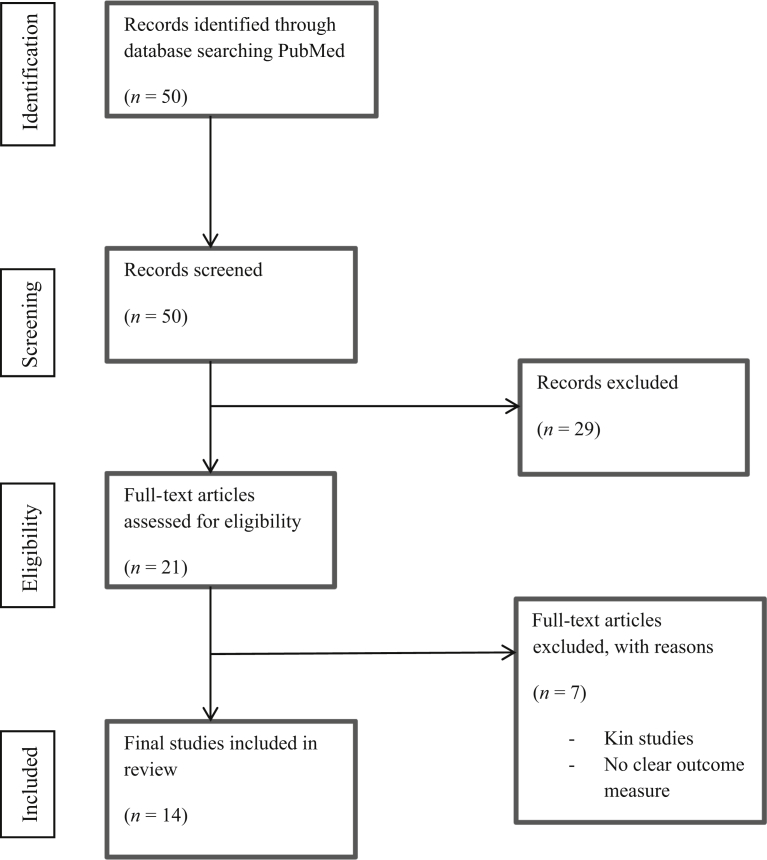
Flow diagram of systematic review synthesis.